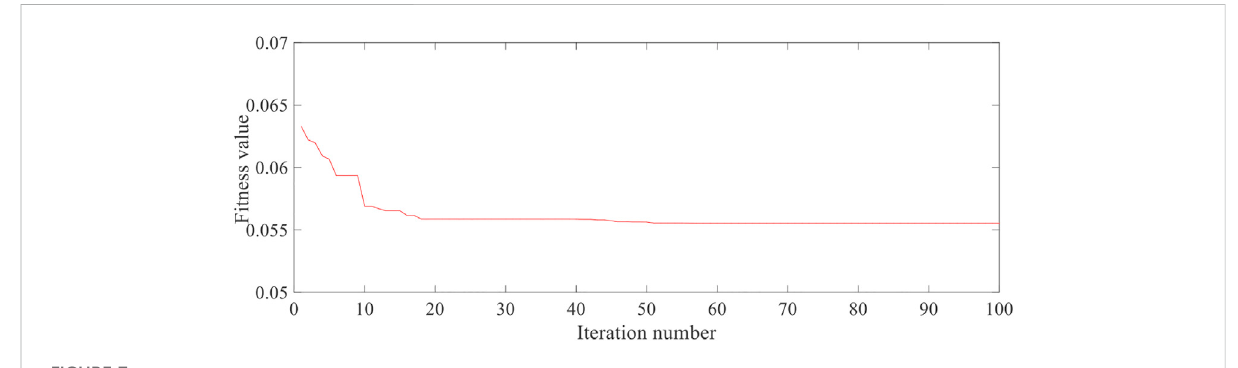
FIGURE 7 Convergence curve of optimization calculation.